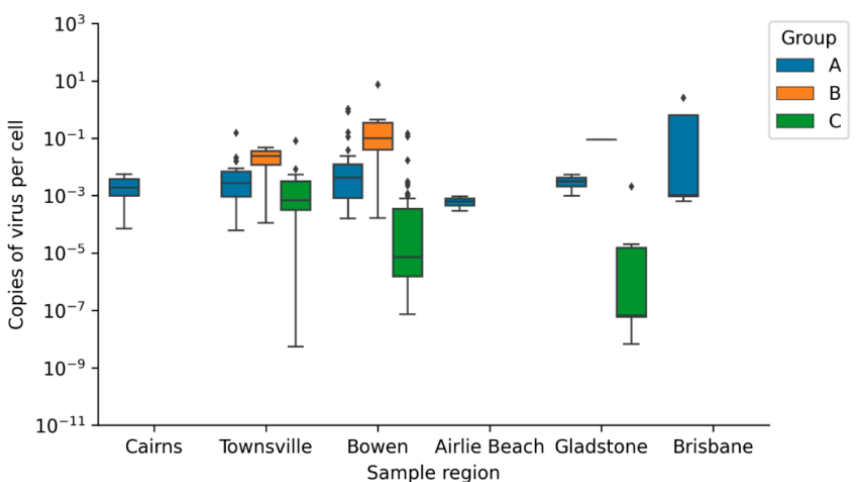
Figure 3. Box-plots of CmPV1 viral loads (log scale) in different sample types from six regions of Queensland. Group A (FP Tumours), Group B (Non-tumoured skin from turtles with FP tumours) and Group C (Skin from non-tumoured turtles). The Box plots of viral loads include the median (centre horizontal line), interquartile range (box), minimum and maximum (whiskers), and outliers